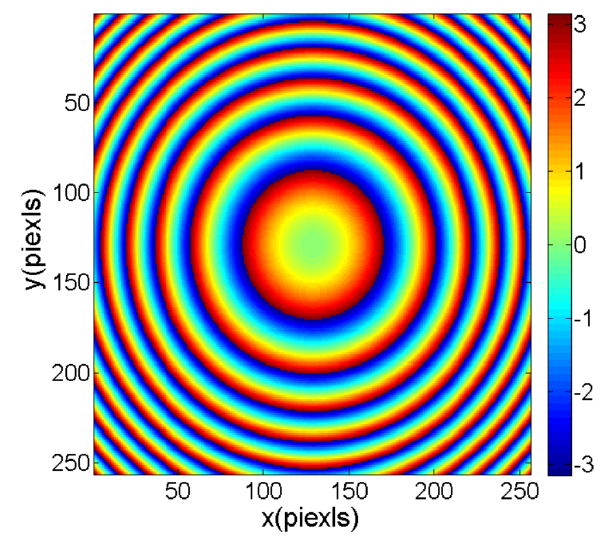
Figure 7. The spherical aberration phase map.